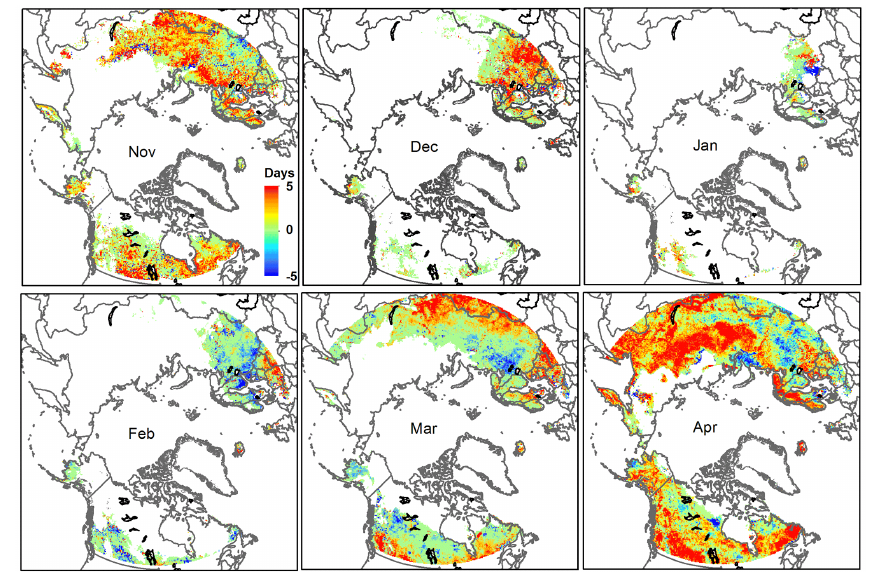
Figure 12. Mann-Kendall trends (days / 26 years) in the number of melt days derived by PMW-fixed from November to April during the period